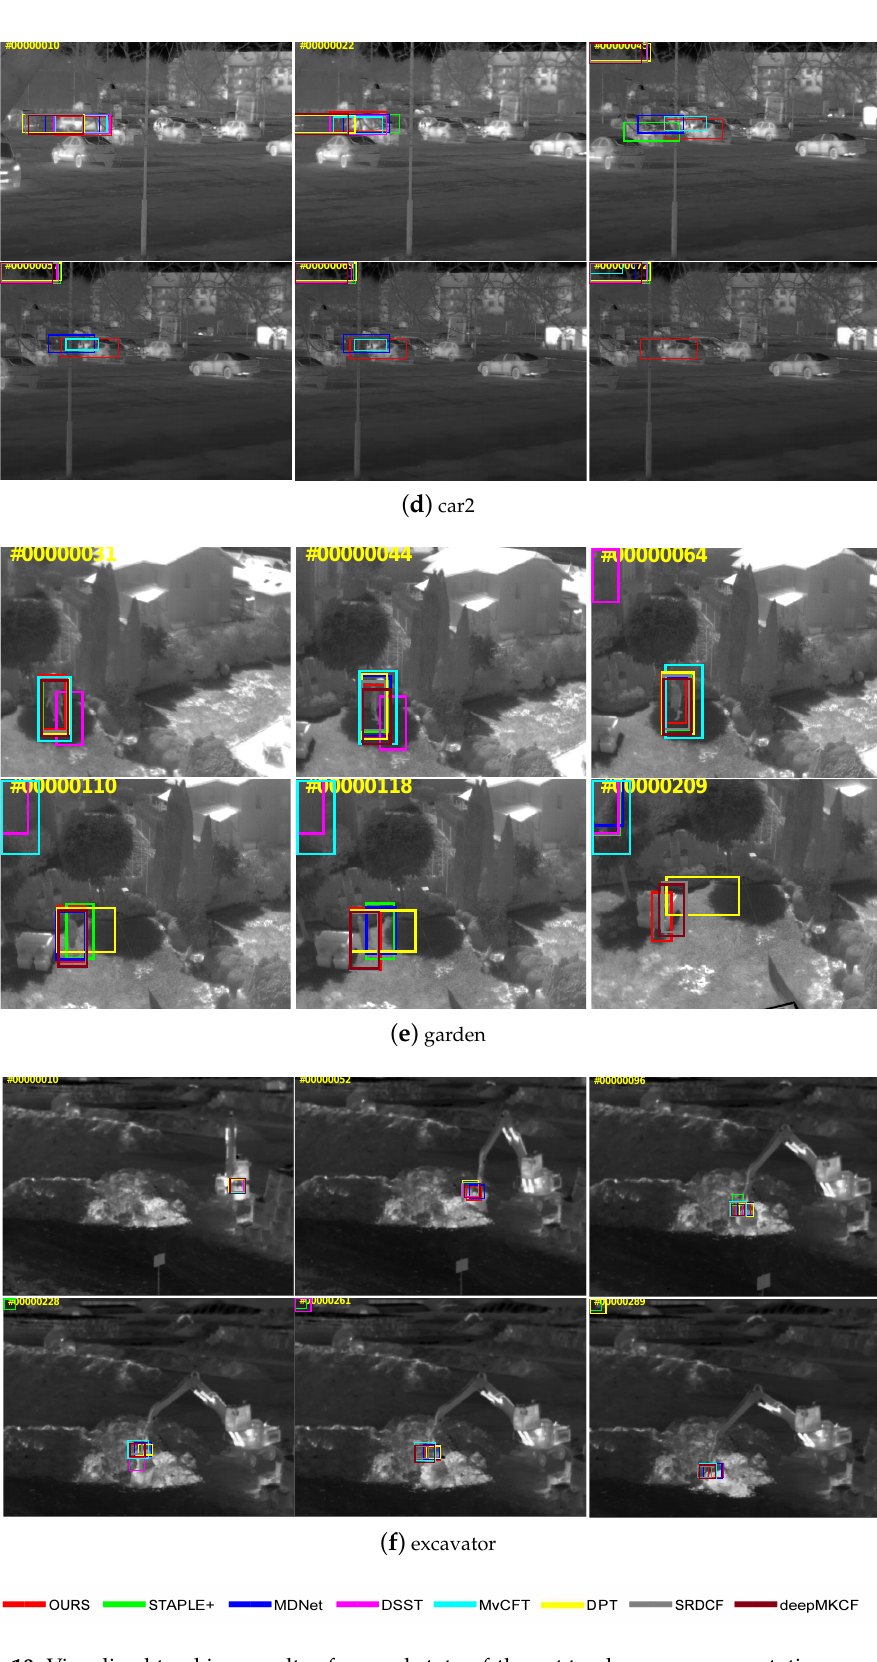
Figure 10. Visualized tracking results of several state-of-the-art trackers on representative